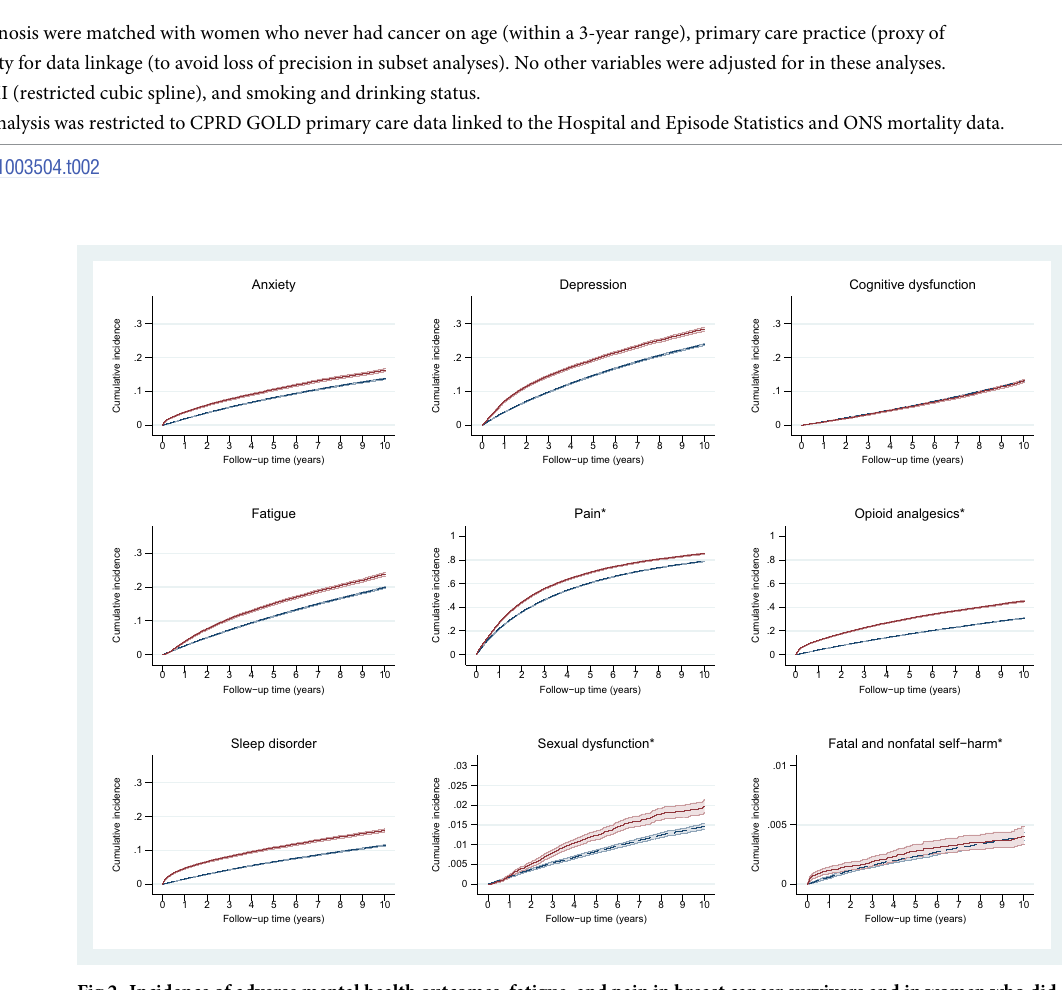
Fig 2. Incidence of adverse mental health outcomes, fatigue, and pain in breast cancer survivors and in women who did not have cancer. Full red line: breast cancer survivors; dashed blue line: women who never had cancer. � Please note the different scale used in this